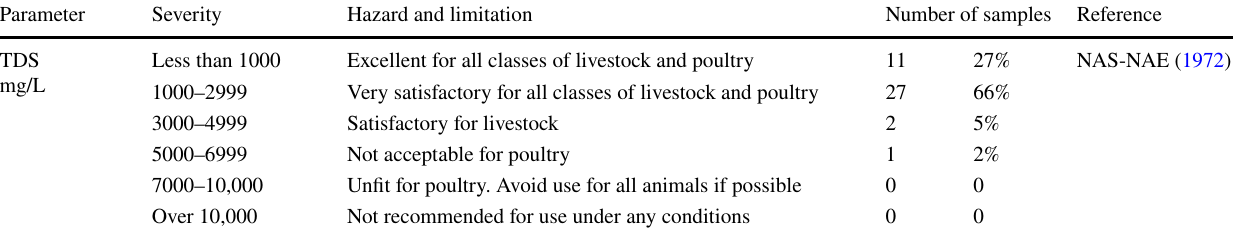
Table 6 Guide to use of saline water for livestock and poultry of groundwater samples in the study area Parameter